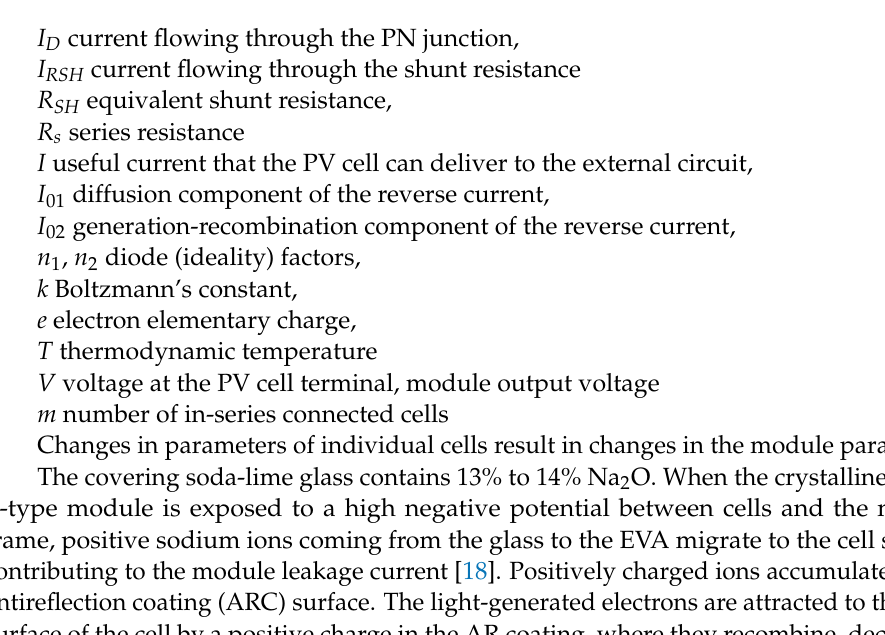
Figure 1. ( a ) Equivalent circuit of serially connected PV cells into the module. ( b ) Simplified equivalent circuit of m serially connected PV cells.